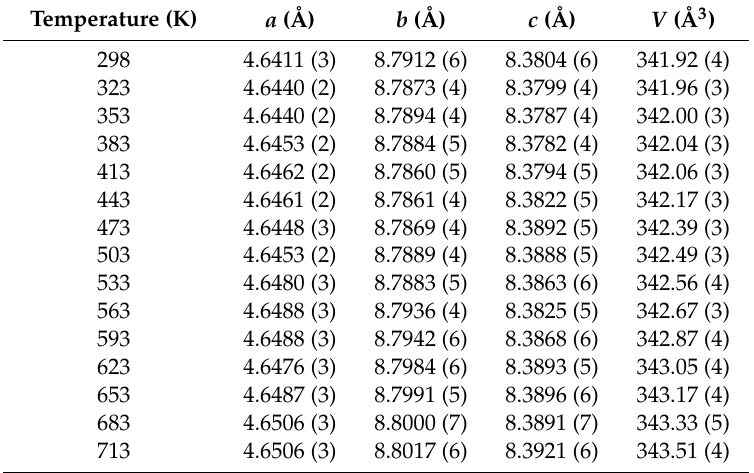
Figure 7. The representative Le Bail profile fitting pattern of topaz at 298 K ( a ), 413 K ( b ), 533 K ( c ), and 713 K ( d ). Observed spectra (black line), fitted spectra (red solid line), difference plot (blue solid line), and Bragg peak positions (tick marks) are shown. Table 3. The unit–cell parameters of topaz at high temperature and ambient pressure.